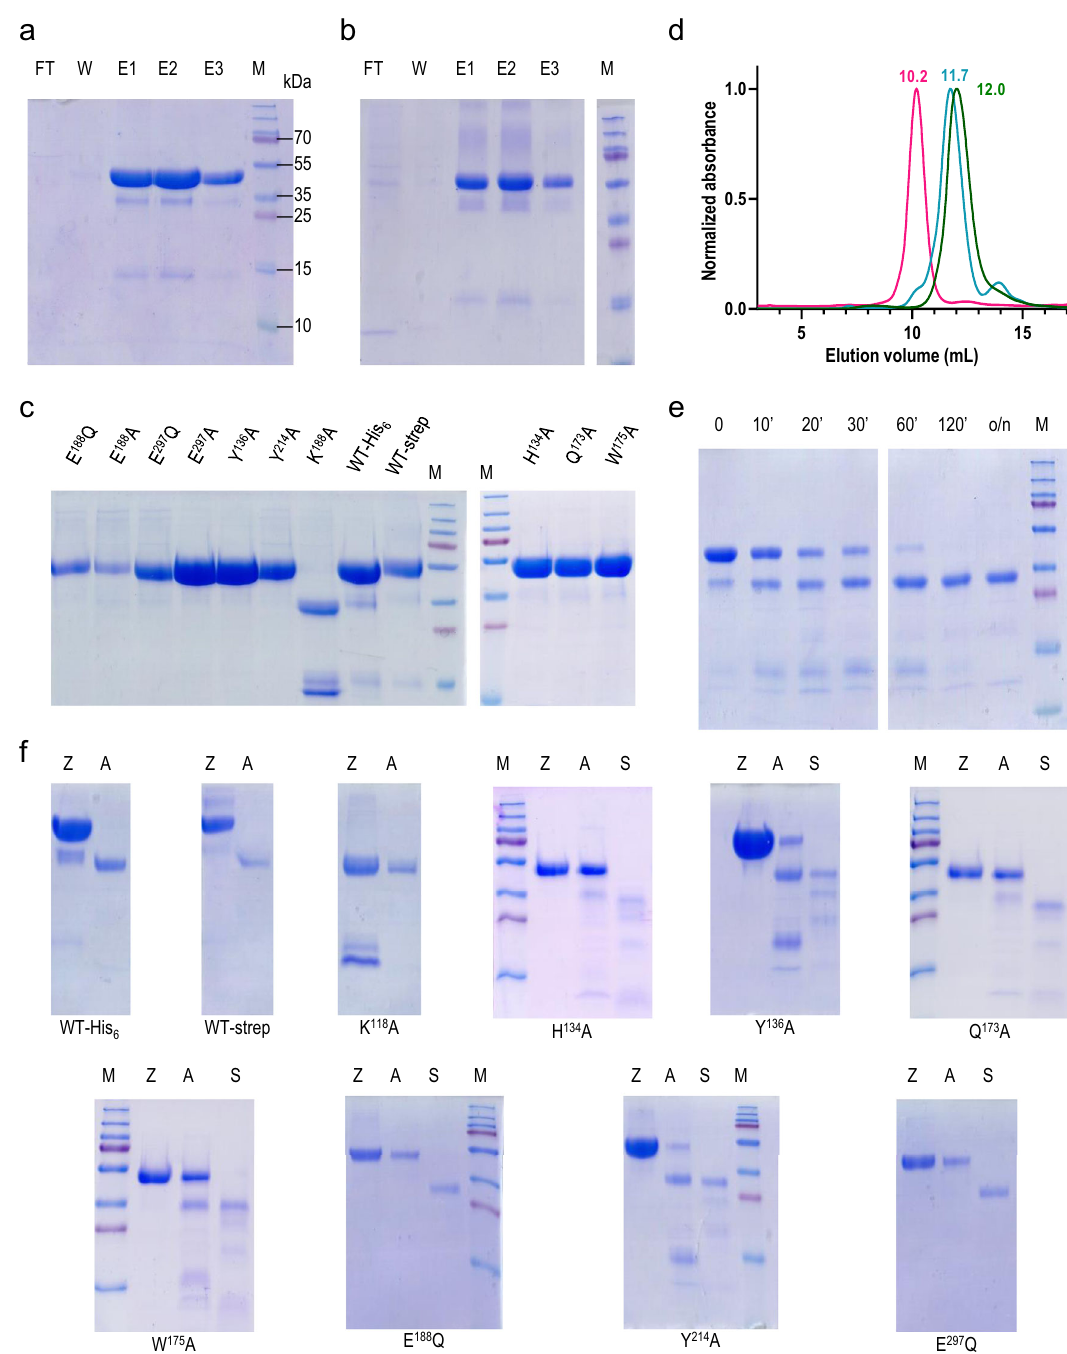
Fig. 1 | Protein puri fi cation and activation. a Puri fi cation of wild-type (WT) pro- neprosin by His 6 - or ( b ) Strep-tag af fi nity chromatography. The fl ow-through (FT), wash (W) and elution (E1 – E3) fractions were analysed by SDS-PAGE and Coomassie staining, alongside molecular mass markers (lane M). Panels are representative of three independent experiments. c Pro-neprosin mutants (K 118 A, H 134 A, Y 136 A, Q 173 A, W 175 A, E 188 A, E 188 Q, Y 214 A, E 297 Q and E 297 A) after His 6 -tag af fi nity puri fi cation com- pared with the WT forms of ( a ) and ( b ). Figure representative of two independent experiments. d Size exclusion chromatography pro fi les of pro-neprosin with His 6 tag (magenta), neprosin with Strep tag (green) and neprosin with His 6 tag (blue) separated on a Superdex 75 10/300 GL column. Each curve is labelled with the